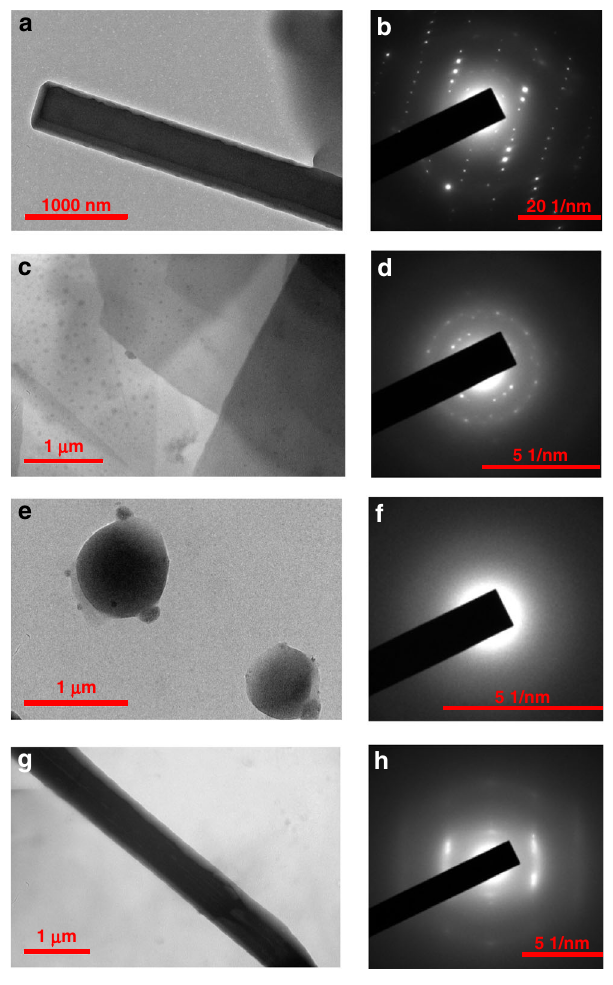
Fig. 10 HRTEM images and the corresponding SAED patterns. a HRTEM image and b SAED pattern of 5 2 (cid:129) 7 (1.00 × 10 − 3 M) with the addition of 4 equiv n -Bu 4 NCl. c HRTEM image and d SAED pattern of 5 2 (cid:129) 8 (1.00 × 10 − 3 M) with the addition of 4 equiv n -Bu 4 NCl. e HRTEM image and f SAED pattern of 6 2 (cid:129) 9 (1.00 × 10 − 3 M). g HRTEM image and h SAED pattern of 6 3 (cid:129) 10 (1.00 × 10 − 3 M) with the addition of 4 equiv n -Bu 4